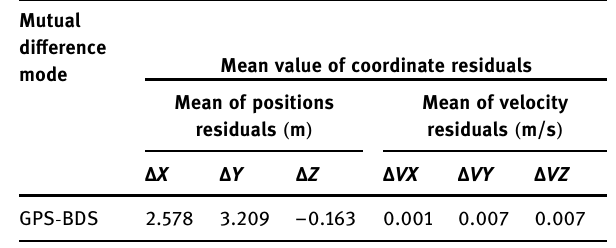
Table 1: Mean value statistics of coordinate